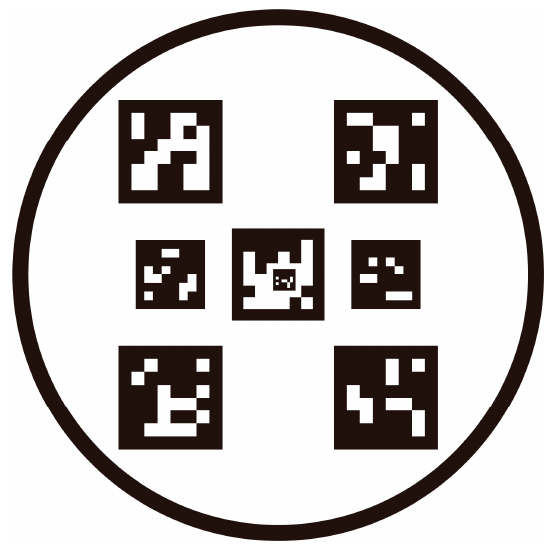
Figure 1. Configuration of the predefined landing pad.